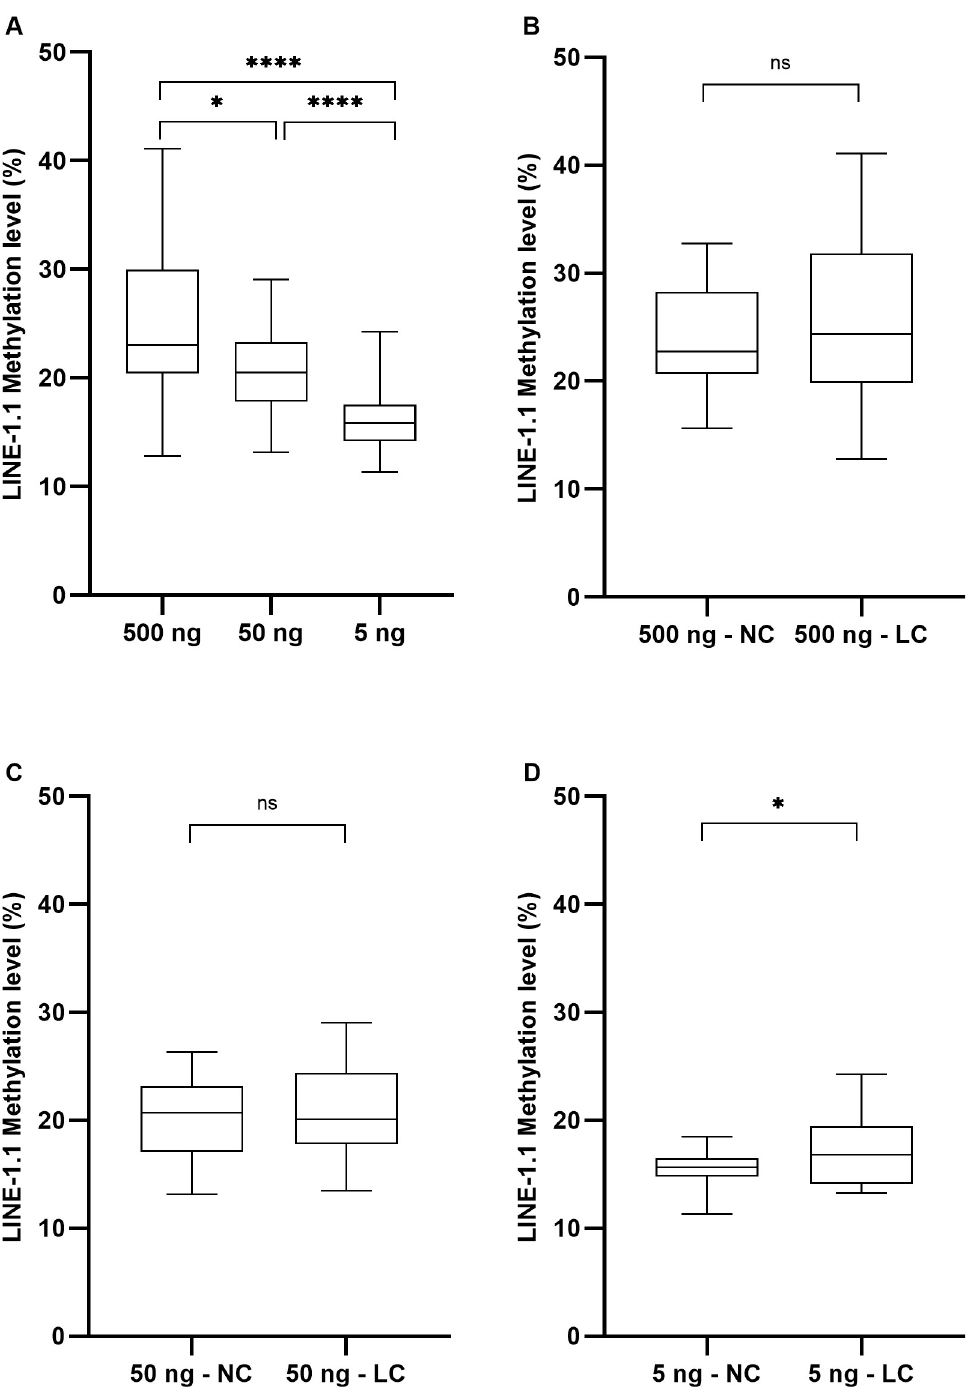
Fig 2. LINE1 methylation level depends on the quantity of input genomic DNA submitted to bisulfite conversion. LINE-1 . 1 methylation level determined from 500 ng, 50 ng or 5 ng of genomic DNA extracted from FFPE tissue and submitted to bisulfite conversion, no matter the samples are lung cancer (LC) or non-cancerous lung disease (NC) (A), in LC versus NC samples when using 500 ng (B), 50 ng (C) and 5 ng (D) of genomic DNAs. ( � ) p < 0.05; ( �� ) p < 0.01; ( ��� ) p < 0.001; ( ���� ) p < 0.0001. One-way ANOVA (A) and Welch’s test (B-D) were used in statistical analysis.